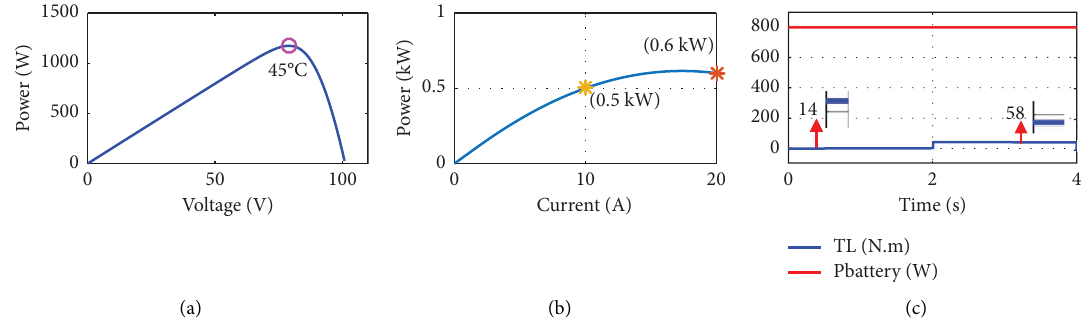
Figure 24: System inputs in the third operation mode. (a) PV characteristic. (b) FC characteristic. (c) Torque and nominal power of the battery.